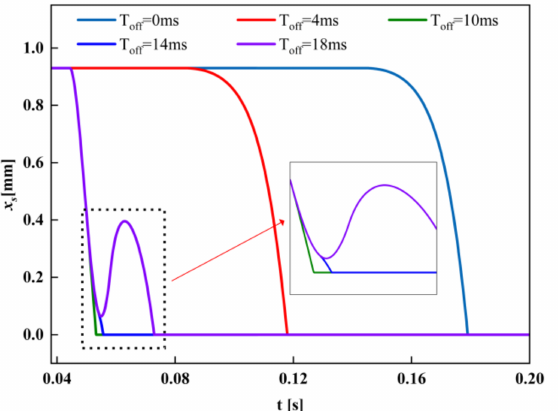
Figure 14. Simulated displacement of the spool under different switching times (T off ) in the closing